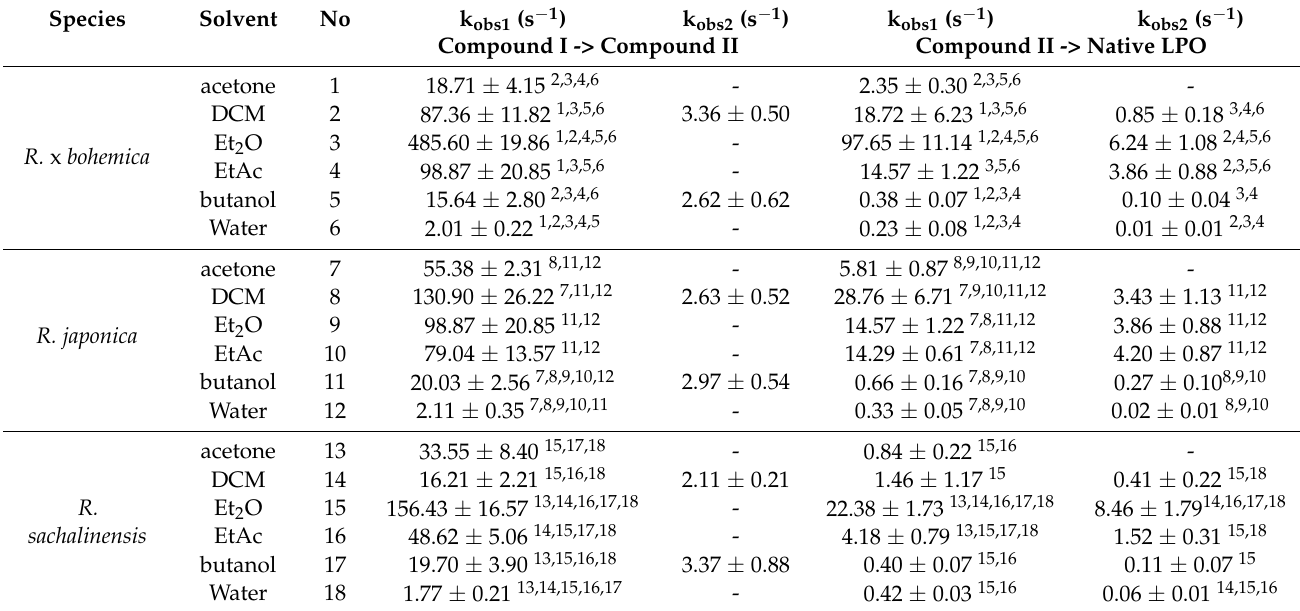
Table 2. The observed rate constants for both investigated reactions in the presence of analyzed extracts in concentration of 5 µ g/mL at 15 ◦ C. The means were calculated from 4–8 replicates, after ‘ ± ’, a standard error is given. For reactions where the kinetic curve was double-exponential, the value of the lower observed rate constant is given as k obs2 . Numbers in superscript indicate significant differences between extracts/fractions of given Reynoutria species with a given number obtained with ANOVA with post-hoc Tukey test.